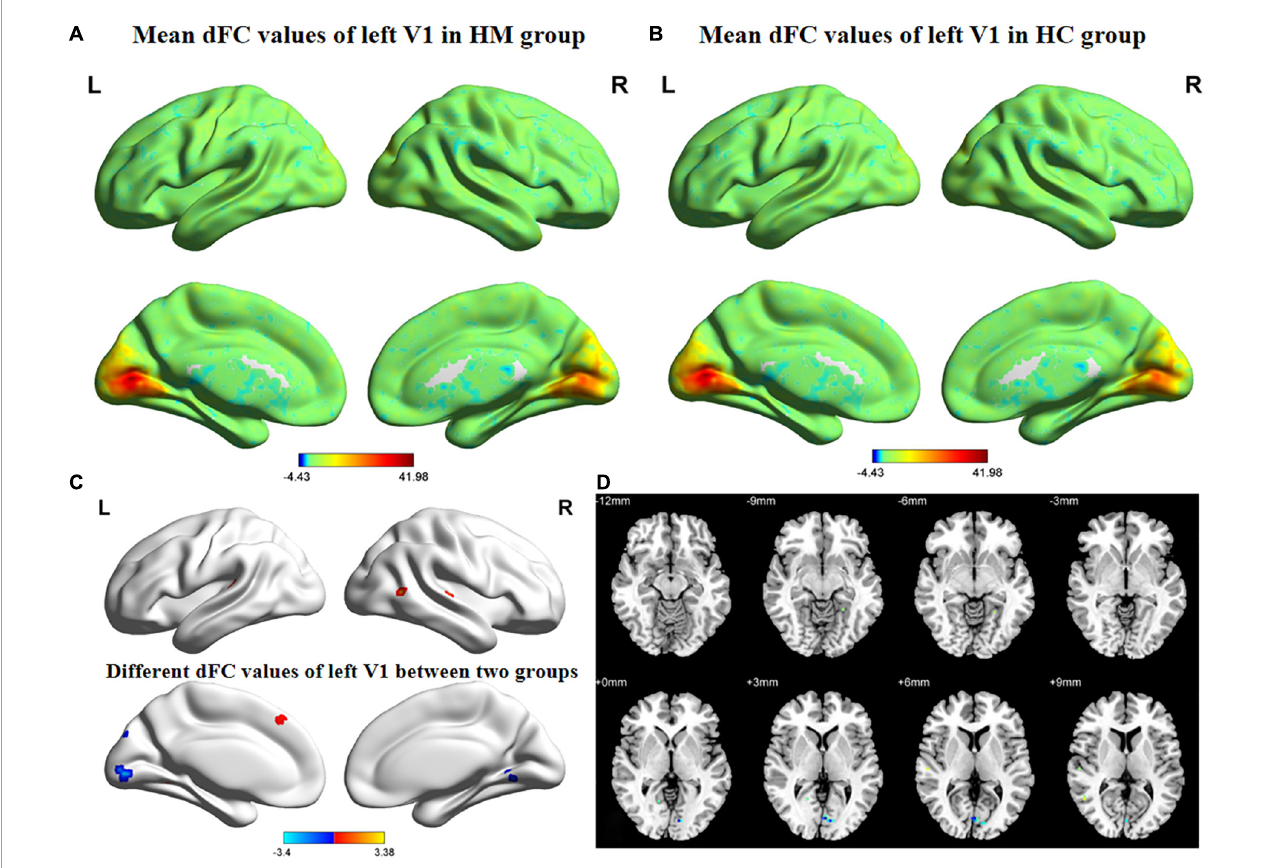
FIGURE3 Spatial of distributions of dFC patterns of the left V1 in HM patients and HCs. (A) Mean dFC values of left V1 in HM group; (B) mean dFC values of left V1 in HC group; (C) different dFC values of left V1 between two groups and (D) significant zdFC maps of left V1 differences among two groups. HCs, healthy controls; HM, high myopia; sFC, static functional connectivity; zdFC, z-values dynamic functional connectivity; L, left; R,